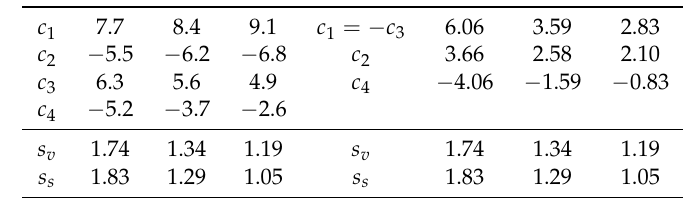
Table 1. The choices of parameters and the corresponding speeds of the vector and scalar GWs. In the left part of the table, c i s are normalized by 10 − 16 and s g = 1 + 7 × 10 − 15 . In the right part of the table, c i s are normalized by 10 − 9 and s g =